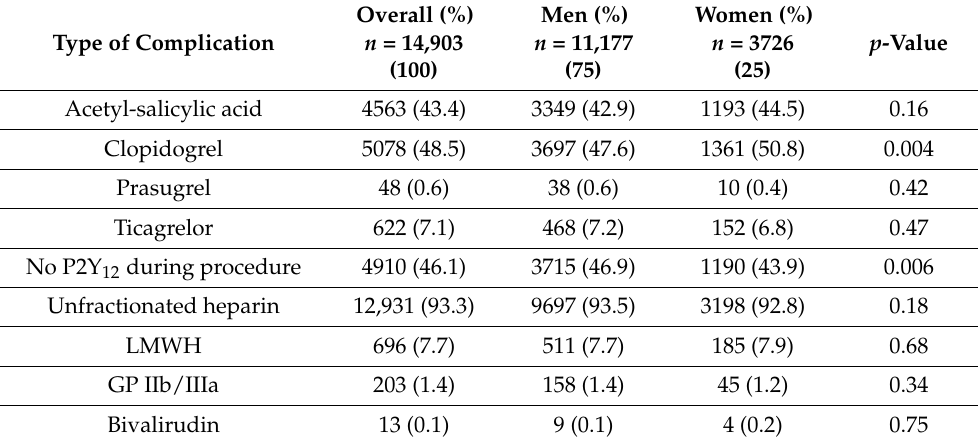
Table 4. Pharmacotherapy during angiography and